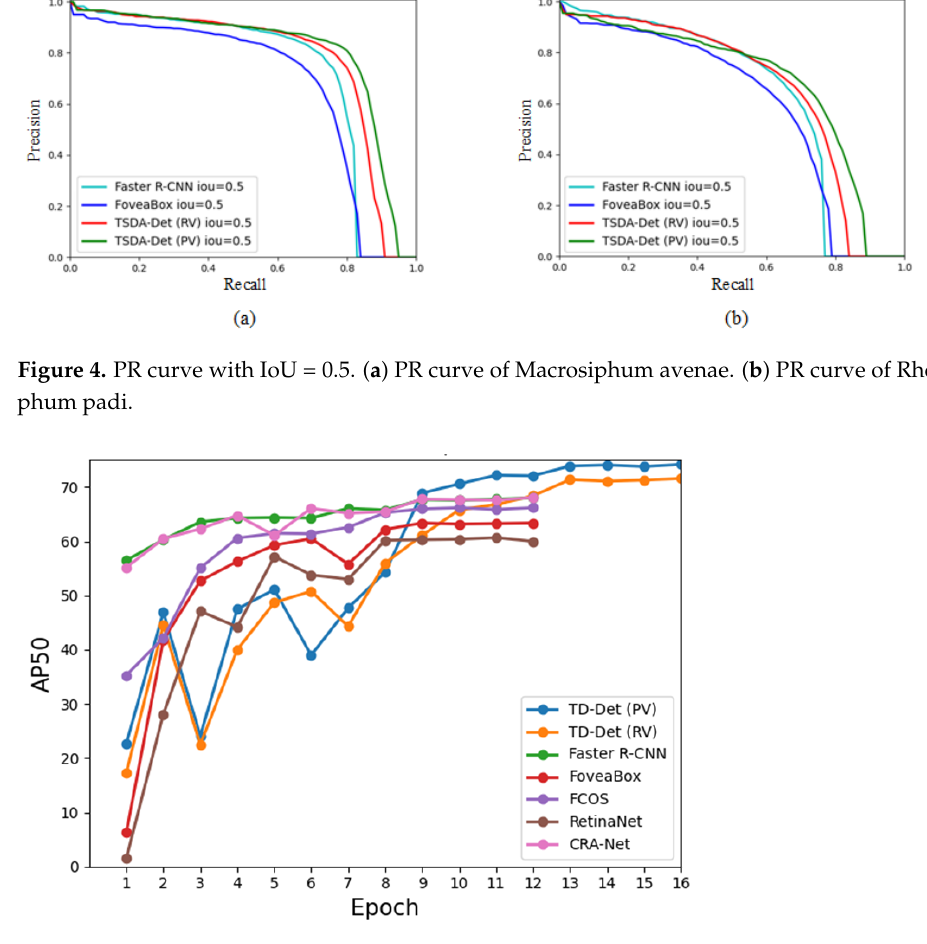
Figure 5. Performance comparison of AP 50